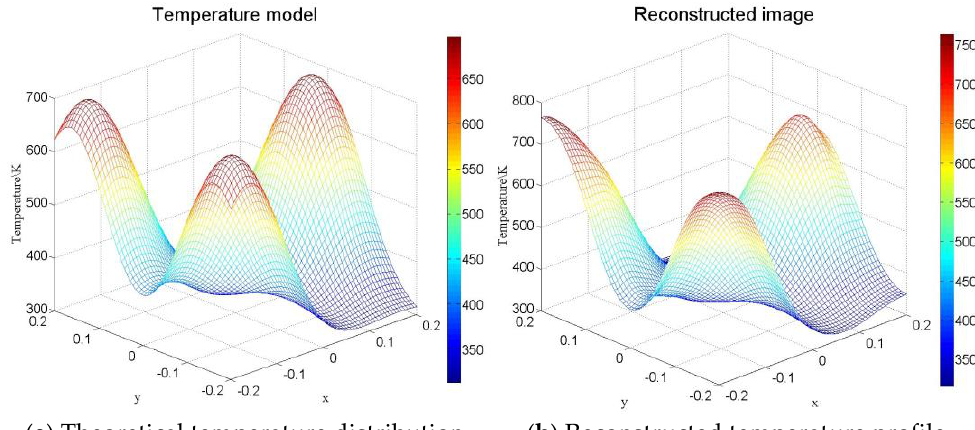
Figure 6 . Stratified temperature distribution (Model II).